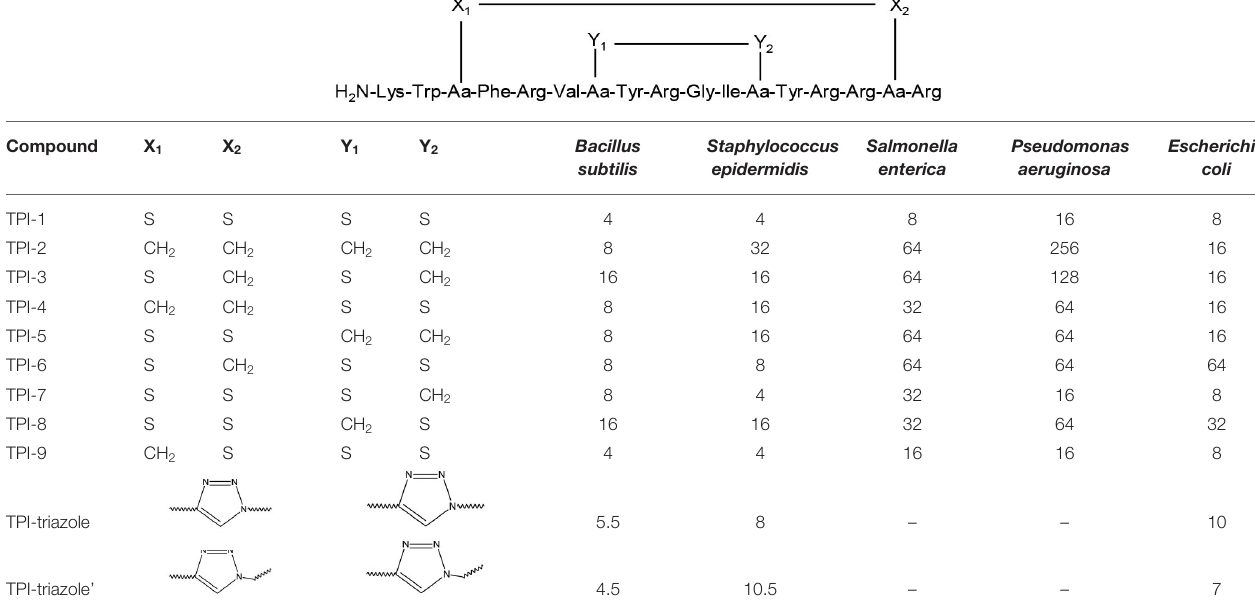
TABLE 2 | The structures of TPI analogues with minimal inhibitory concentrations (MIC) values by the standard 2-fold dilution protocol in µ g × mL − 1 (Cui et al.,